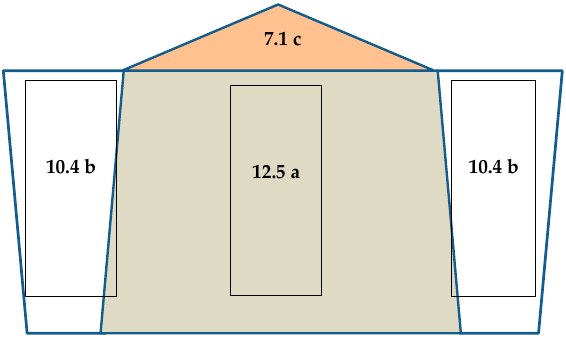
Figure 6. Spatial differentiation of soil moisture (% v/v ) immediately after sowing winter barley. The letters a, b, and c indicate significant difference at p < 0.05.